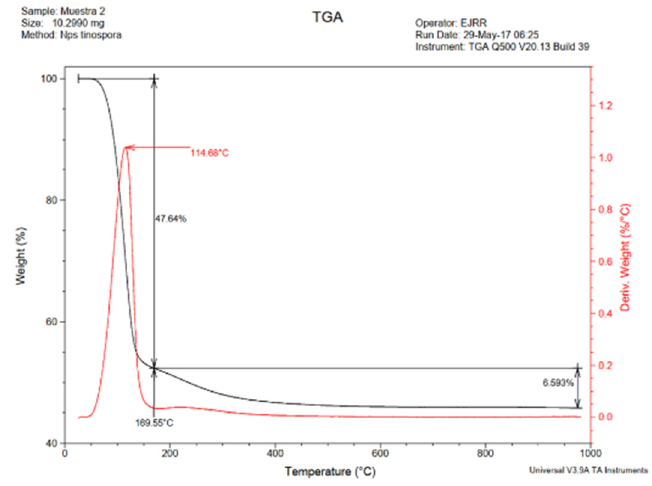
Figure 7. Thermogravimetric (black line) and derivative thermogravimetric (red line) curves resulting from the TGA analysis of the biofilm produced by C. maltosa SM4 cultivation at 200 rpm and 1 L min − 1 .